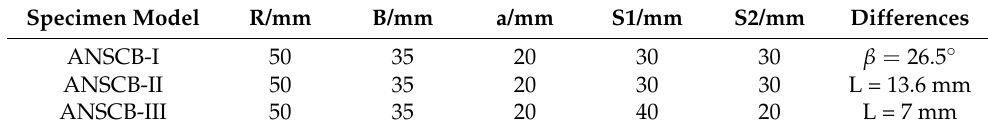
Figure 1. Diagrams and photos of three different asymmetric notched semi-circular bending speci- mens. The circles on the top and bottom of the specimen represent the loading and supporting roll- ers, respectively. it should be noted that the white-black speckle on the sample surface can be ana- lyzed by the DIC method. Table 2. Dimensional parameters of three asymmetric notched semi-circular bendings.